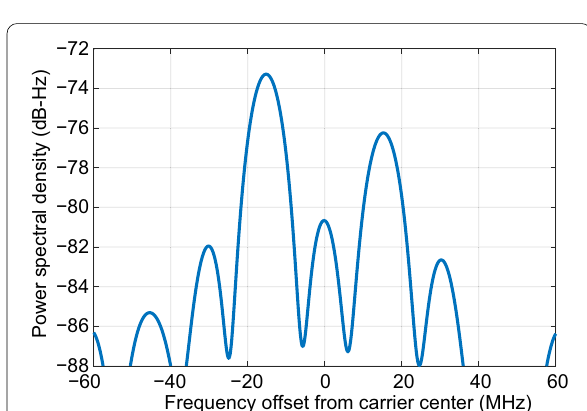
Fig. 4 Multiplexing modulation power spectral density of Type-III ACE-BOC